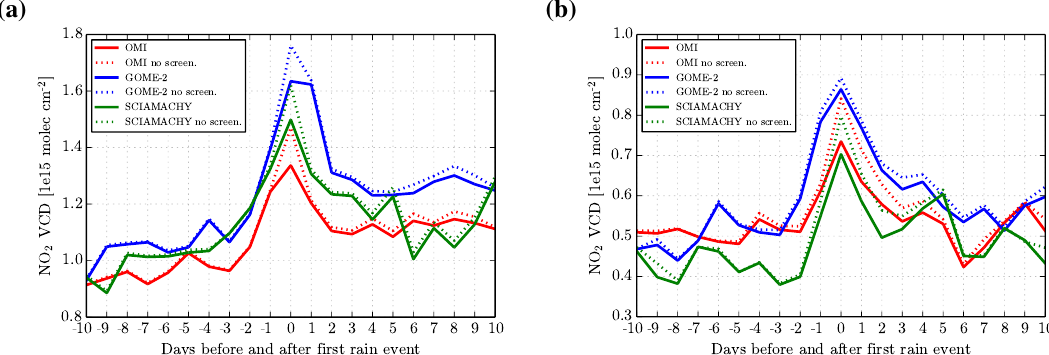
Figure 8. Effect of lightning screening on the response of NO 2 VCDs around the first day of rainfall after a prolonged dry spell. (a) NO 2 VCDs for the Sahel region from SCIAMACHY, GOME-2 and OMI without lightning screening (dashed lines) and with lightning screening (solid lines). (b) The corresponding results for central Australia (15–30 ◦ W, 2–10 ◦